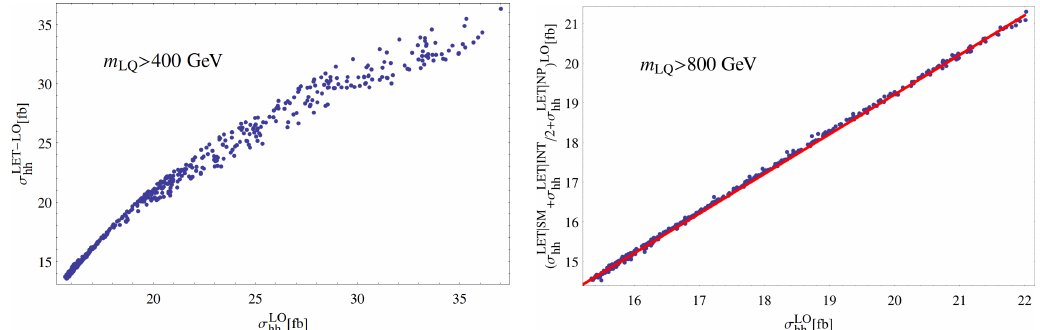
Figure 4. On the left we show σ hh using LET and full calculation at LO, allowing one of the LQ masses to have a lower bound of 400 GeV, whereas the others are larger than 800 GeV. On the right, considering the LET and all LQ masses larger than 800 GeV, we show σ LET | SM σ LET | NP , that is: we correct the interference term by a factor 1/2, the red line is the identity, shifted hh by a constant value to compensate the underestimation of the SM cross section using the LET.